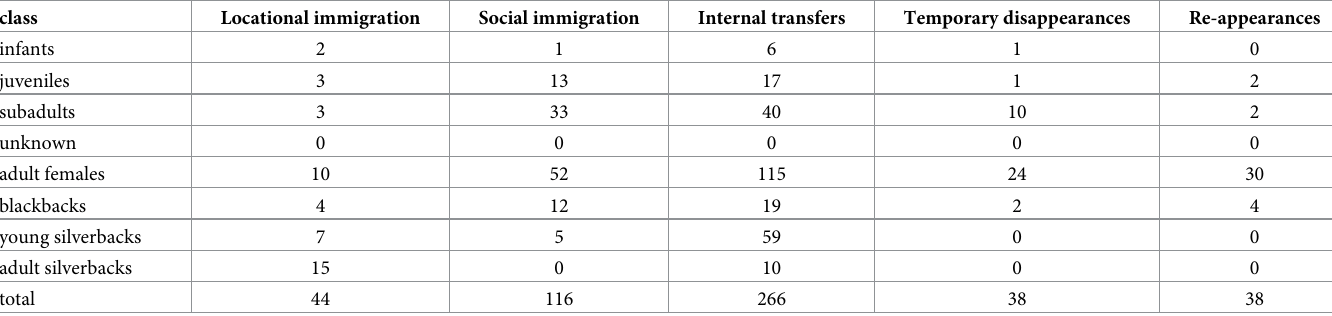
Table 2. Sample sizes for the number of gorilla movements and